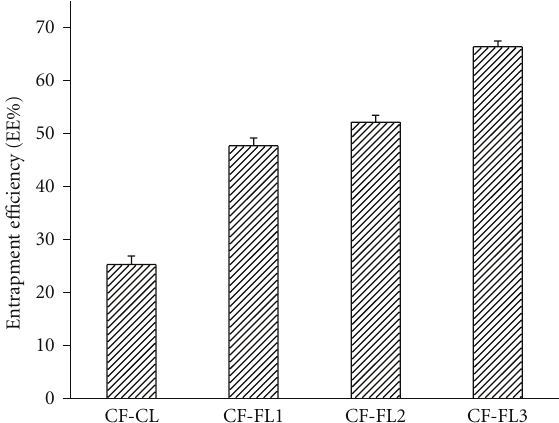
Figure 1: The entrapment e ffi ciency of carboxyfluorescein- (CF-) loaded di ff erent liposomes: (CF-CL: conventional liposomes; CF-FL1: flexible liposomes containing sodium cholate; CF-FL2: flexible liposomes containing tween 80; CF-FL3: flexible liposomes containing cineole and